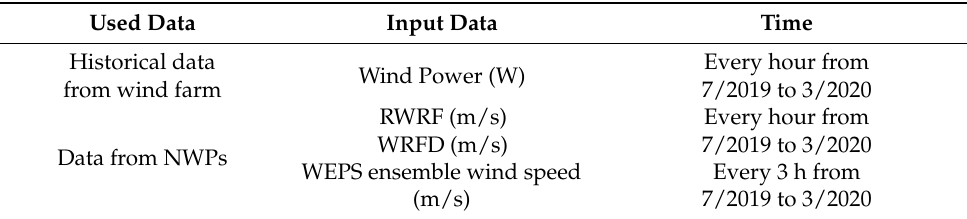
Table 1. Input data description.